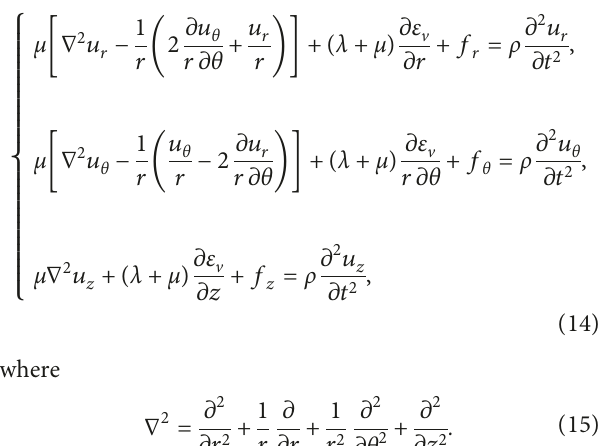
Figure 1: Analytic